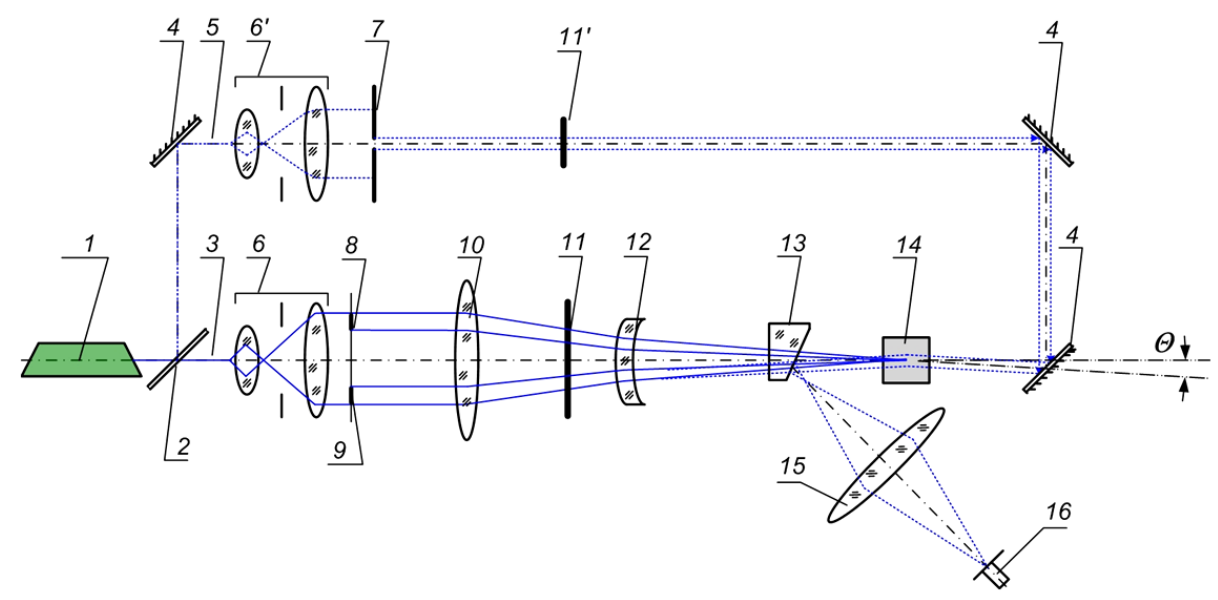
= 3 × 10 17 cm − 3 ) crystal: 1 : Ar laser; 2 : semitransparent mirror; 3 : recording ( N Ga